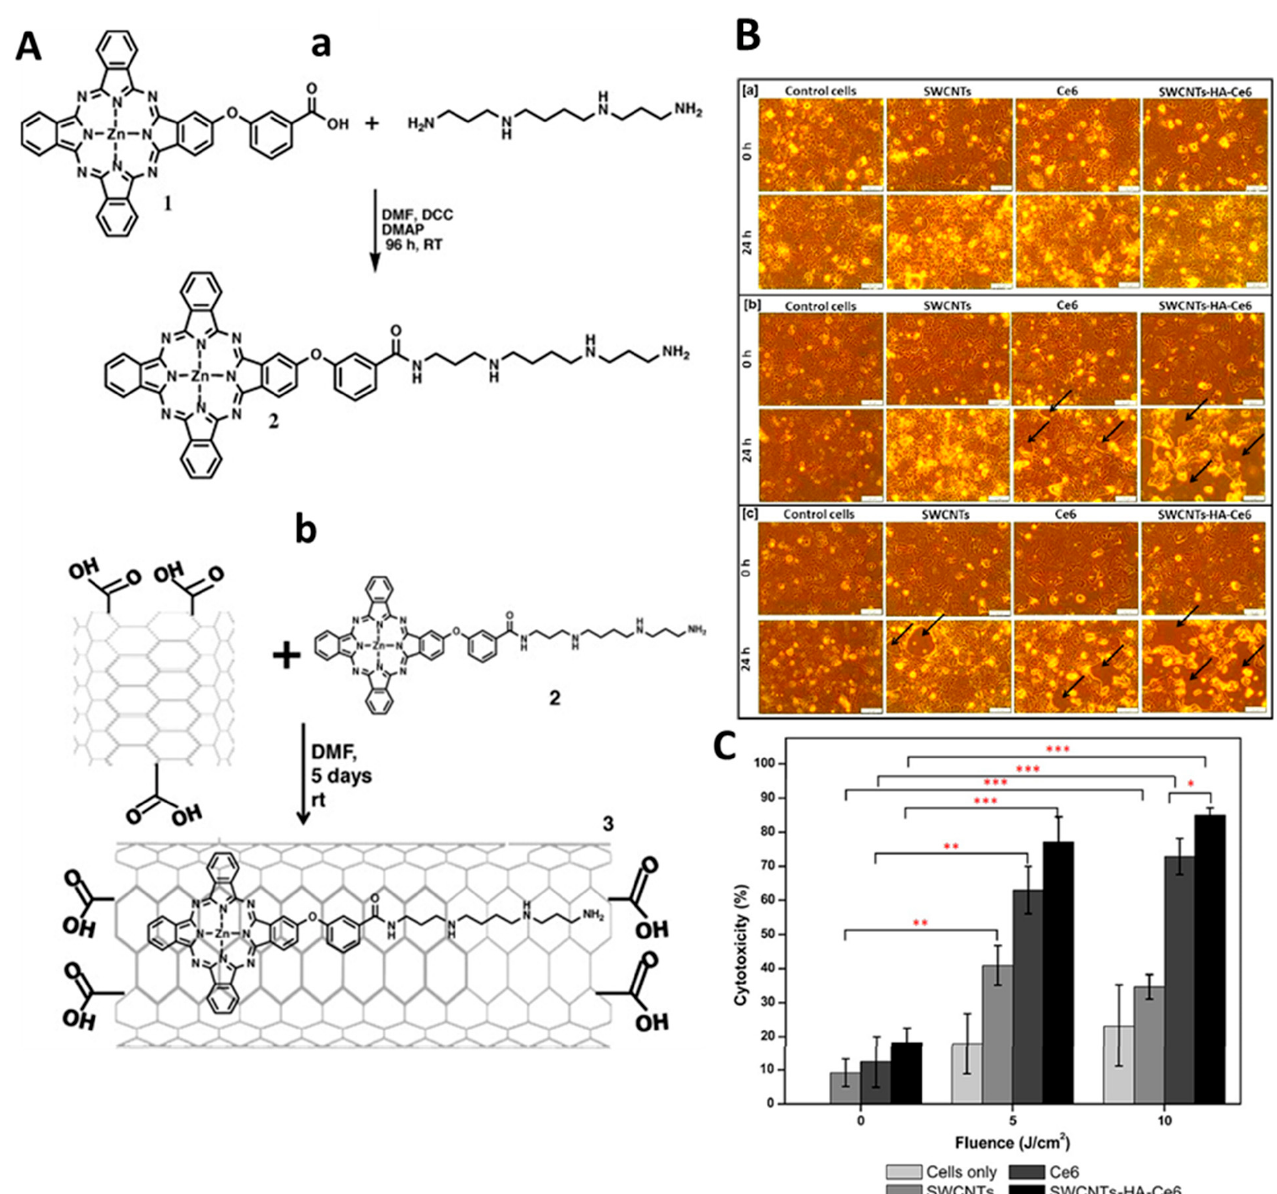
Figure 13. ( A ) Synthetic routes for ( a ) ZnMCPPc-spermine-SWCNT ( 2 ) and ( b ) ZnMCPPc-spermine- SWCNT ( 3 ). Reprinted with permission from Synthetic Metals, Copyright 2015, Elsevier [106]. ( B ) Microscopic images of untreated and treated cells. ( a ) Group 1 cells (untreated) at 0 h and 24 h, ( b ) Group 2 cells (5 J/cm 2 ) at 0 h and 24 h ( c ) Group 3 (10 J/cm 2 ) cells at 0 h and 24 h. Scale bar represents 100 μ m. Black arrow indicates the cellular death. ( C ) The cytotoxicity effects of SWCNTs, Ce6, SWCNT-HA-Ce6 on Caco-2 cells determined by LDH assay. Significance is shown as * p < 0.05; ** p < 0.01; *** p 0.001 [108].